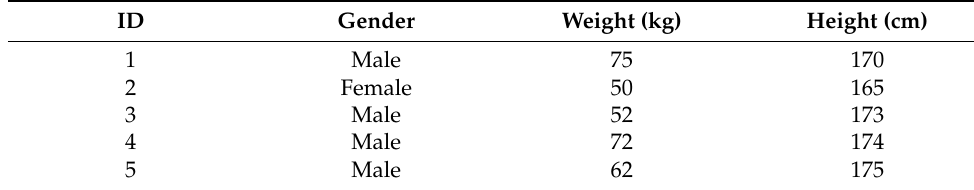
Figure 6. Collection schematic. Table 2. Details for five